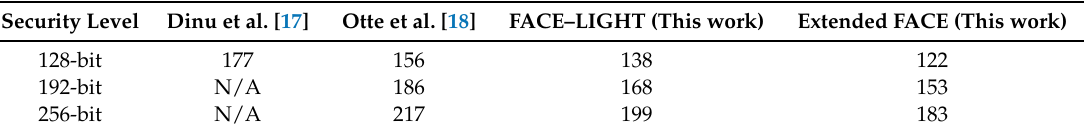
Table 1. Comparison of AES on 8-bit AVR (Alf and Vegard’s RISC processor)microcontrollers, in terms of clock cycles per byte.